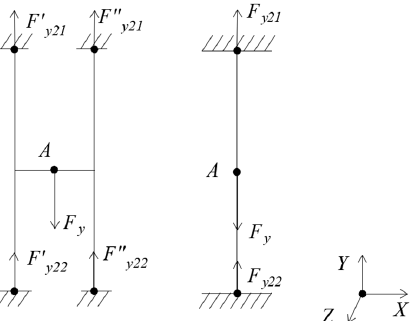
Figure 4. Mechanical models of floating beam and H-beam under F y.